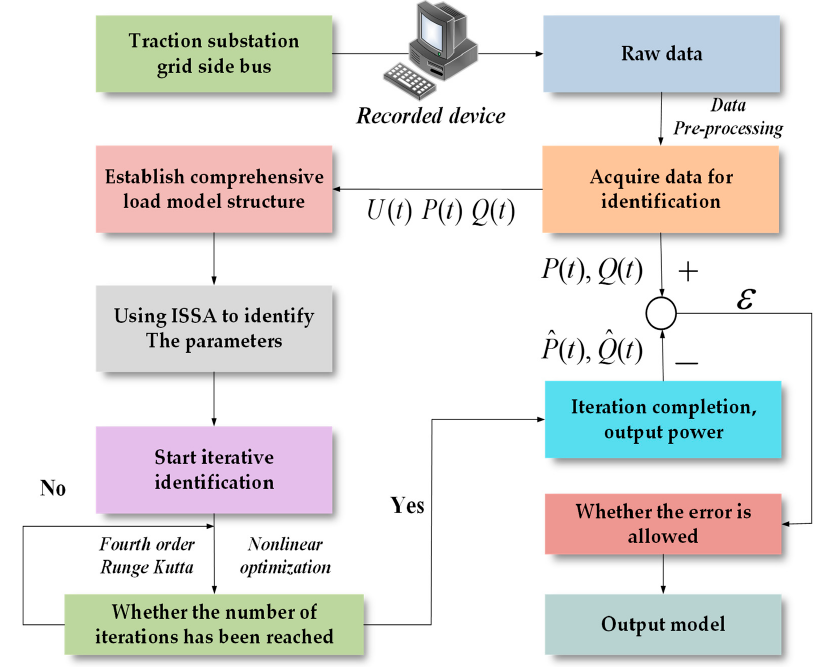
Figure 7. Schematic diagram of parameter identification process.